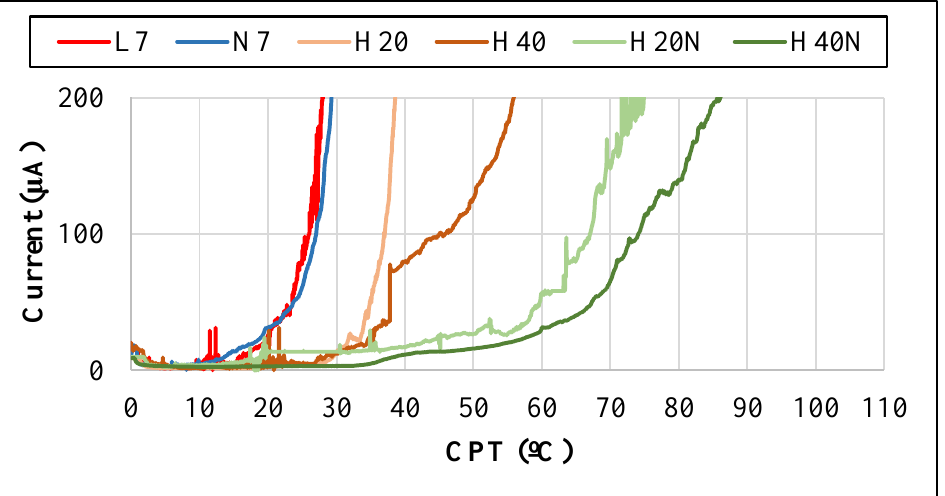
Figure 11. Graph with CPT test curves from each weld bead and base metal, showing the current reaching 100 μA.